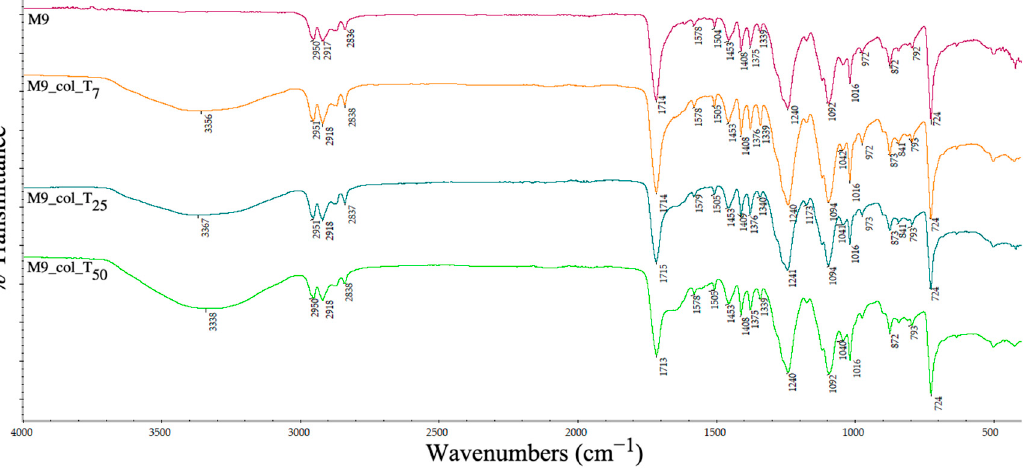
Figure 22. ATR spectra of PET–PP–Fe nano-power embedded pellets before and after collagen deposition at days 7 (T 7 ), 25 (T 25 ) and 50 (T 50 ).